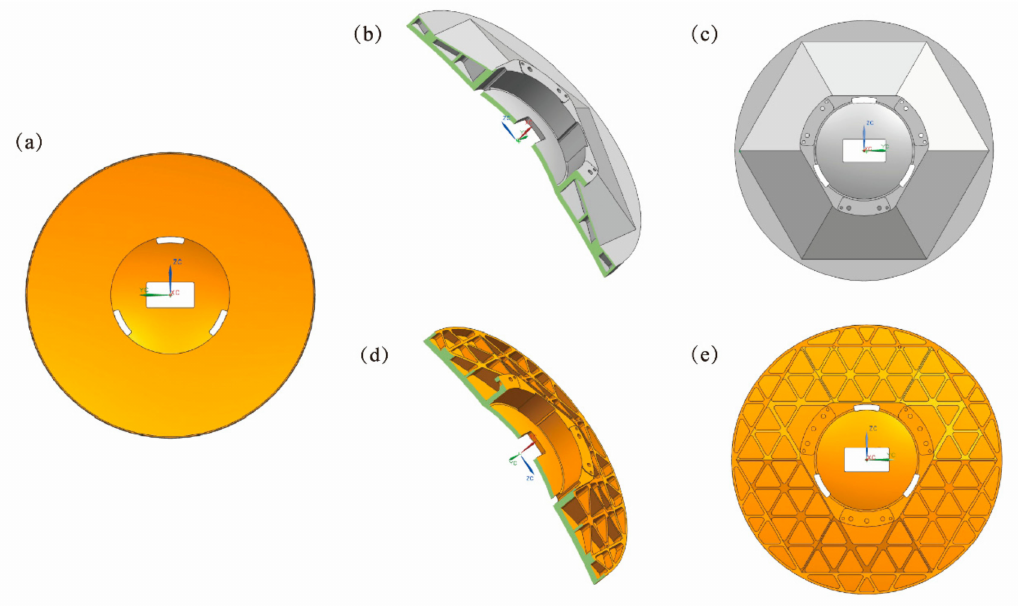
Figure 3. Schematic diagram of mirror models: ( a ) front view of the mirror; ( b ) half-section of the closed-back mirror; ( c ) back view of the closed-back mirror; ( d ) half-section of the open-back mirror; and ( e ) back view of the open-back